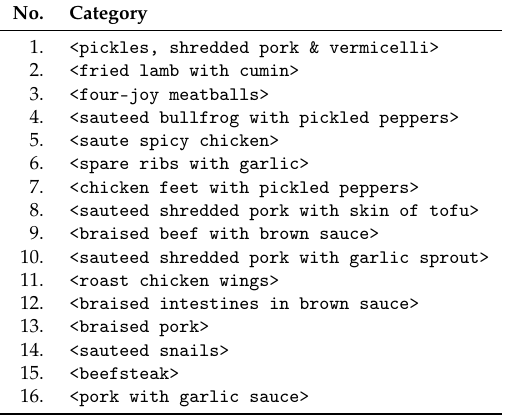
Table 2. VireoFood-172 meat categories, randomly selected to form smaller dataset D (cid:48) .